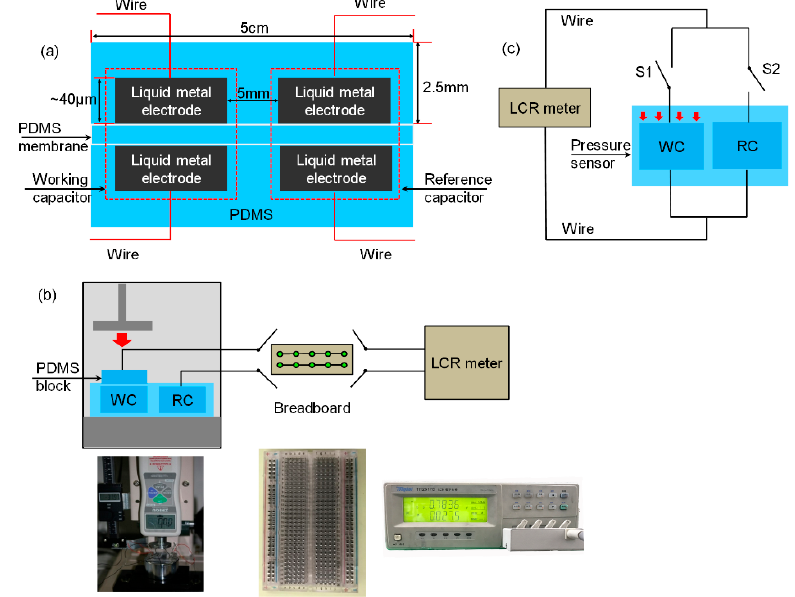
Figure 6. ( a ) Structure of the double-capacitor sensor; ( b ) measurement setup of the experiment; ( c ) equivalent circuit of the measurement.